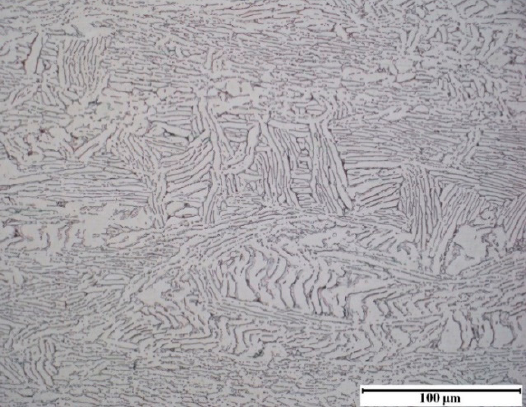
Figure 1. Initial microstructure of the specimens of TA15 titanium alloy.